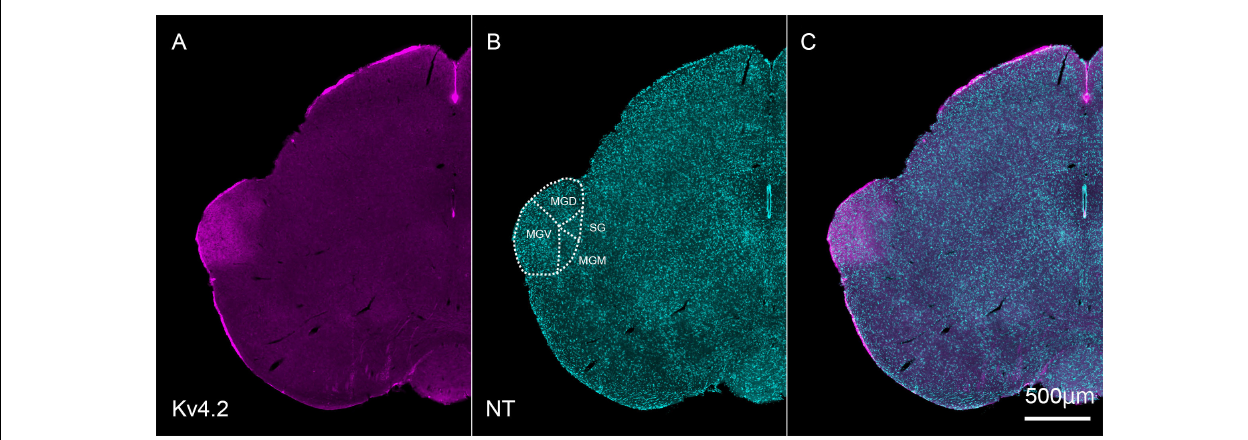
FIGURE 2 | Kv4.2 protein expression in the MGB examined by immunohistochemistry. (A–C) Double fluorescence for voltage-dependent potassium channel 4.2 (Kv4.2, magenta: A ), NeuroTrace 435/455 (NT, cyan: B ), and merged (C) labeling in the adult mouse brainstem coronal section, including MGB. Scale bar: 500 µ m. MGB, medial geniculate body; MGD, dorsal MGB; MGM, medial MGB; MGV, ventral MGB; NT, NeuroTrace; SG, suprageniculate